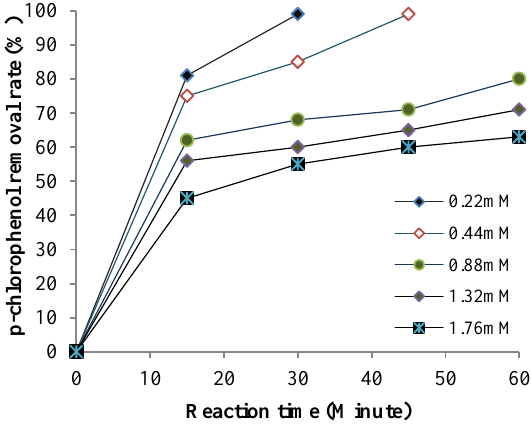
Figure 5. Influence of initial p-chlorophenol concentration on its degradation Initial experiments conditions: pH = 3, zerovalent iron = 1 mM, PS = 3 mM Degradation Rate